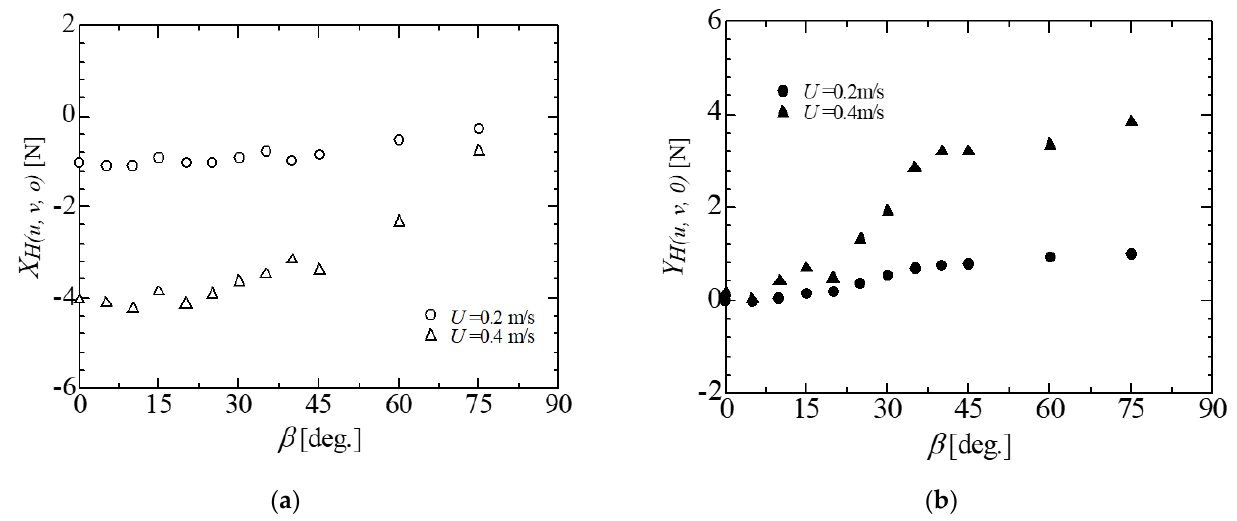
Figure 8. Variation of the fluid force with the drift angle: ( a ) x -axis; ( b ) y -axis.